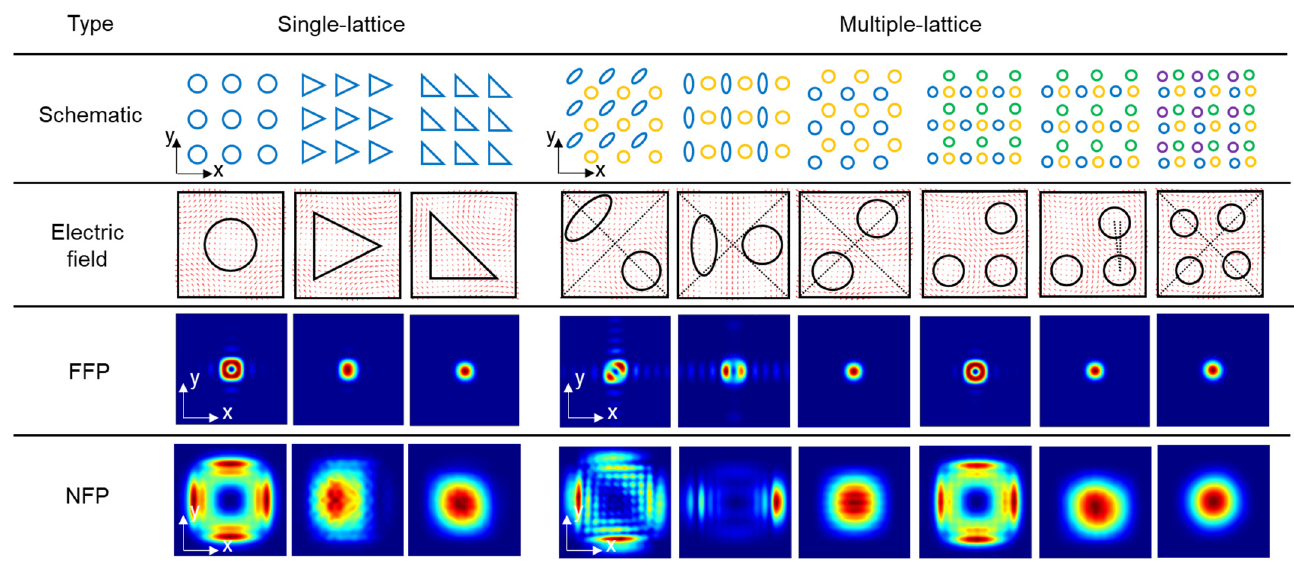
Figure 3. The schematic of various in-plane PhC structures and their corresponding electric field, FFP, and NFP. The period number of PhC is 31. and NFP. The period number of PhC is